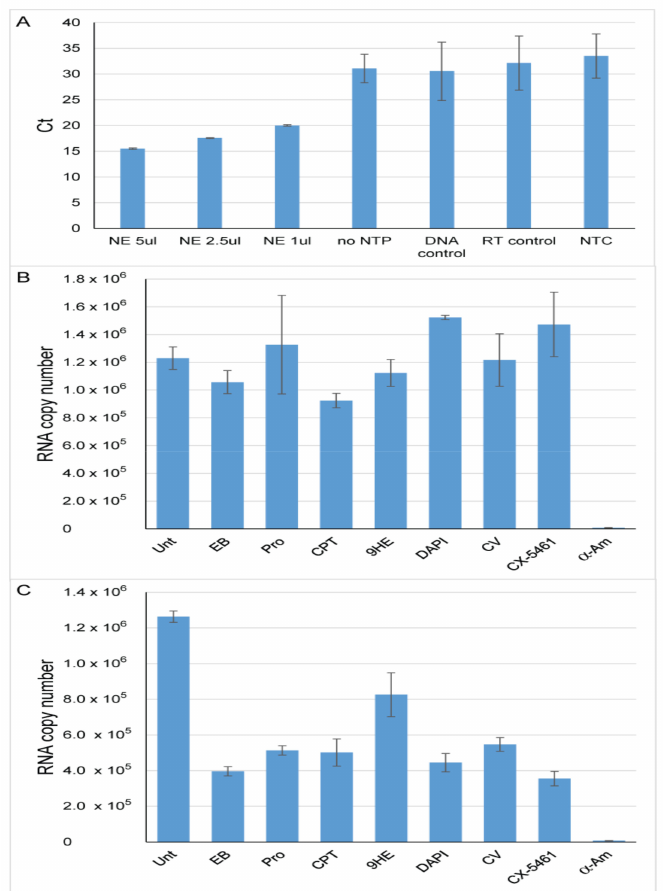
Figure 3. DNA intercalators/groove binders have limited effect on specific Pol-II driven transcrip- tion. In vitro transcription was performed and analyzed as described in Material and Methods. ( A ) Ct values for positive and negative controls were plotted in a bar graph. Standard deviation from three independent experiment are shown; n = 3. Positive controls: In vitro transcription reac- tions were supplemented with 5, 2.5 and 1 µ L of HeLa NE as indicated. Negative controls: